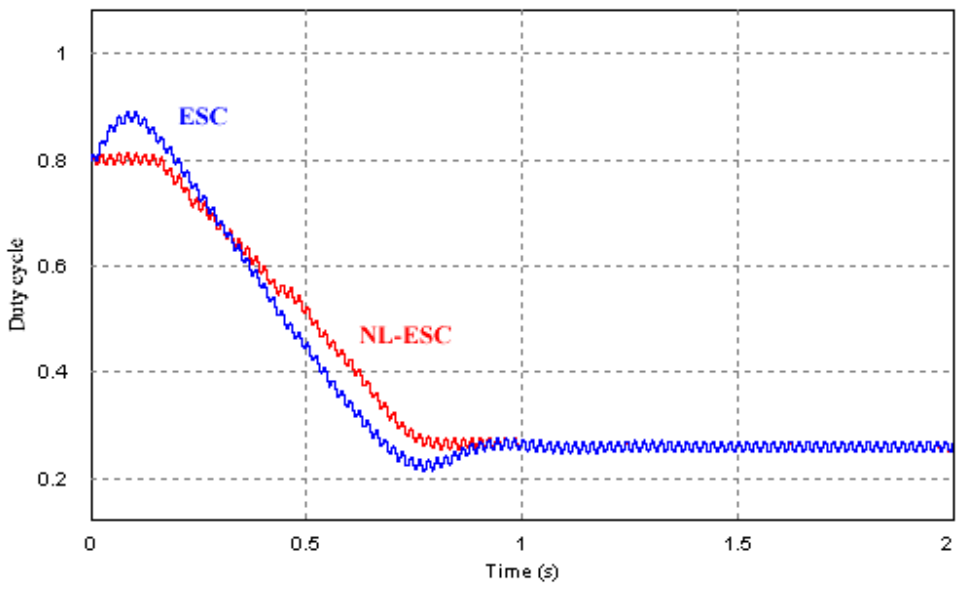
= 0.8 in NL-ESC case ( Red ); i = 0.8 in ESC case ( Blue ). i